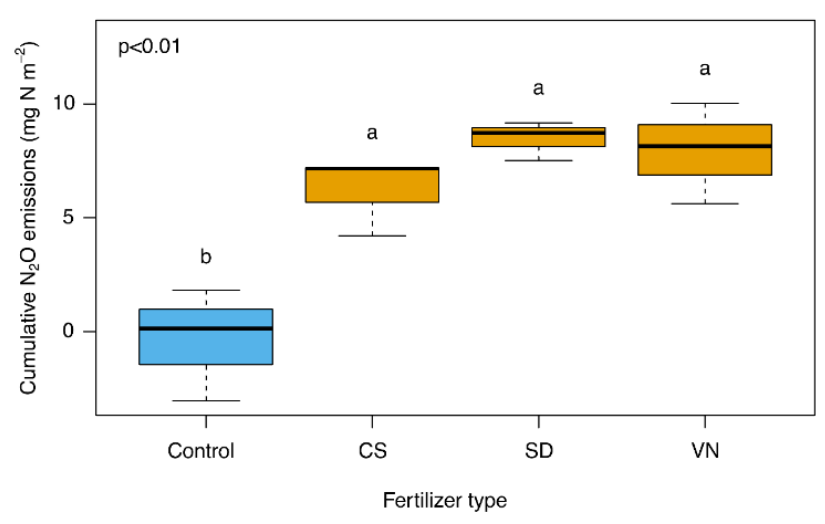
Figure 2. Total cumulative N 2 O fluxes (mg N m −2 ) for the different studied fertilizers (Control: soil; CS: cattle slurry; SD: slurry digestate; VN: vinasse) without biochar amendment for the considered period (20 days). p -value for one-way ANOVA for fertilizer type.